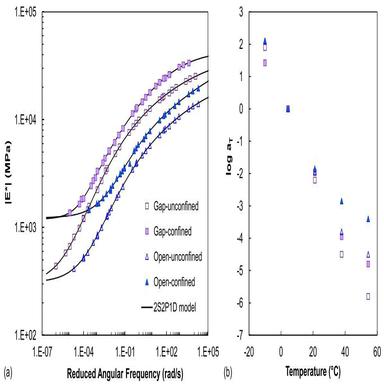
The dynamic modulus results: (a) master curves (and the 2S2P1D model fits, and (b) time-temperature shift factors.